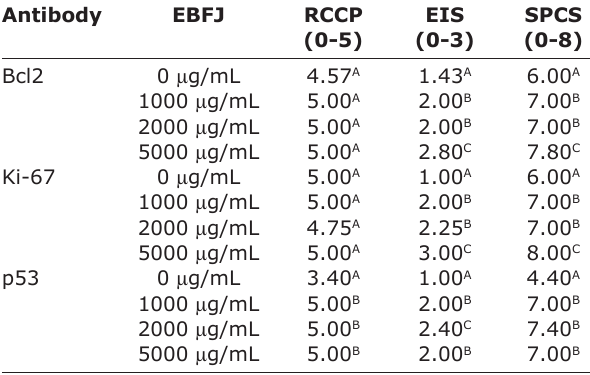
SPCS=Semi-quantitative combined scoring system